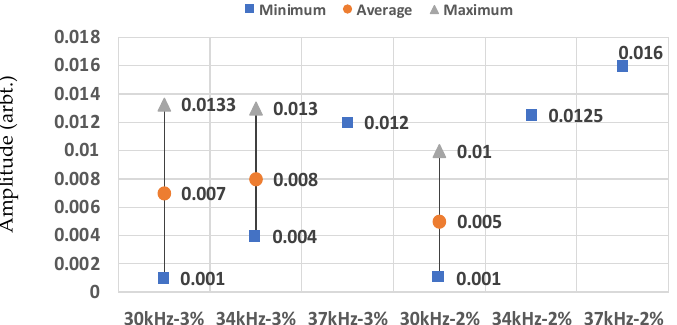
Figure 11. Minimum, average, and maximum values of method one of the first set of tests.